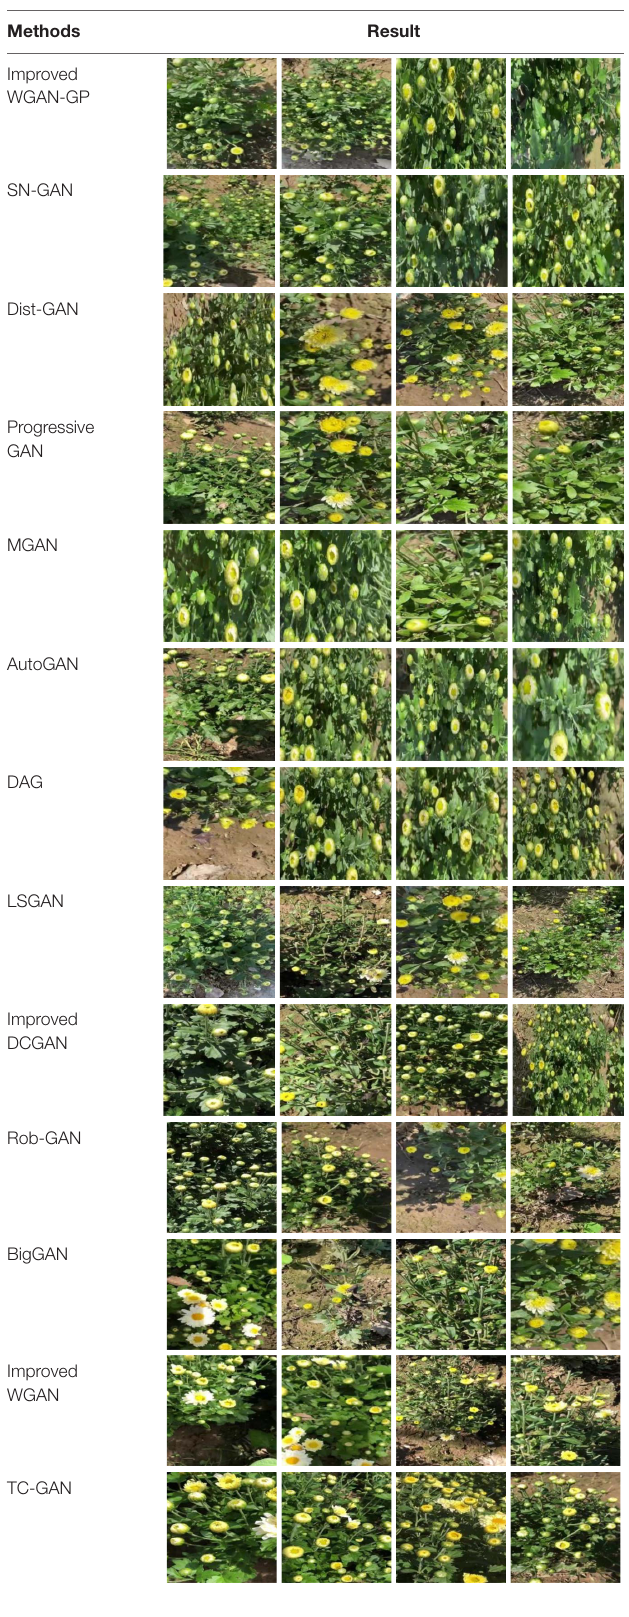
TABLE 7 | Generation results of different